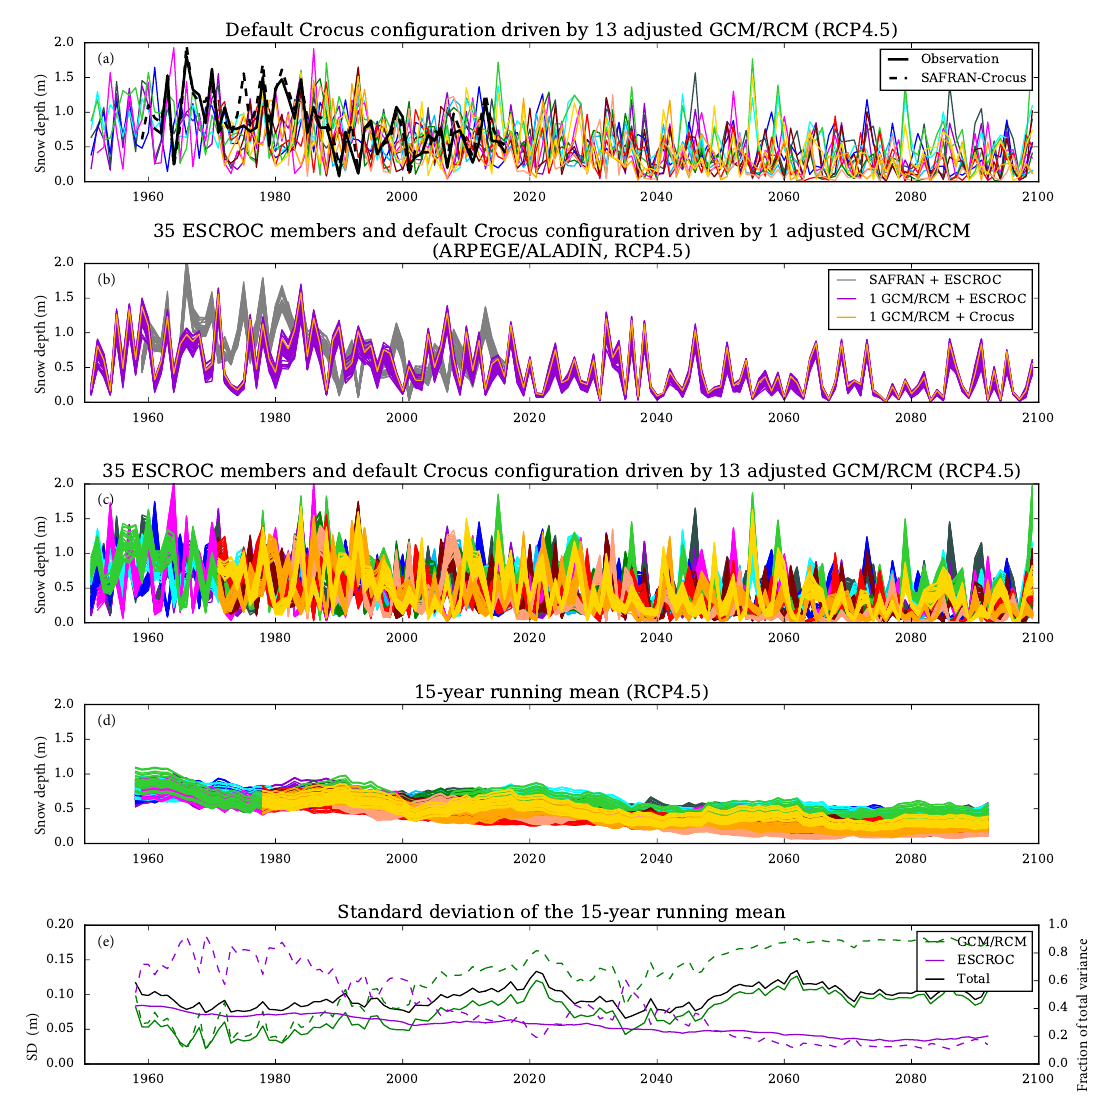
Figure 2. Observed and simulated time series of SD. (a) Continuous time series of annual values of mean winter snow depth data (SD), either observed or generated by the default snowpack model configuration fed by meteorological data from a reanalysis or an adjusted RCM. (b) SD values obtained using the ensemble of Crocus model configurations ESCROC. (c) Ensemble of Crocus model configurations driven by the 13 RCP 4.5 GCM–RCM pairs; each GCM–RCM pair is displayed with a different color. (d) Fifteen-year running average values of all simulation members presented in (c) . (e) Estimate of absolute and relative contribution of uncertainty components arising from GCM–RCM intermodel variability and multiphysics snowpack model uncertainty